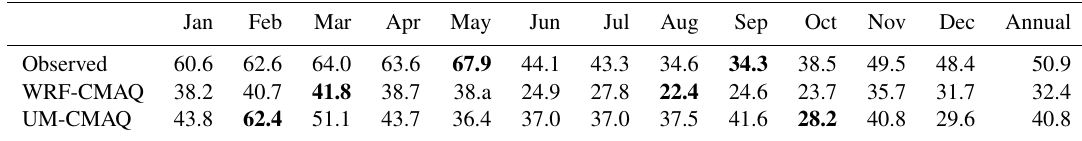
Table 4. Observed and modeled surface PM 10 concentrations (µgm − 3 ) over surface monitoring sites in the SMA, South Korea. Bold values indicate maxima and minima.